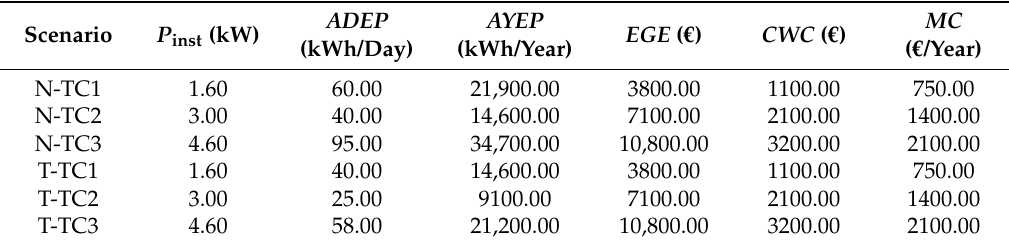
Table 2. Economic feasibility of PATs installation in a WDN: Production and Cost analysis for cases with no tank (N-) and with tank (T-). EGE: energy generation equipment; CWC : civil work cost; and MC : maintain